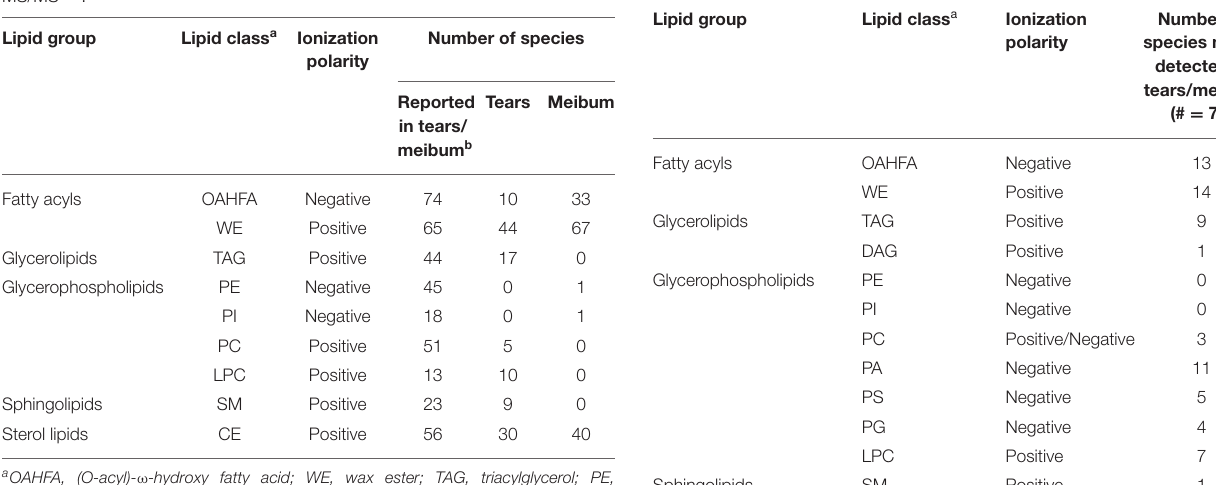
TABLE 3 | New lipid species detected by using MS/MS ALL